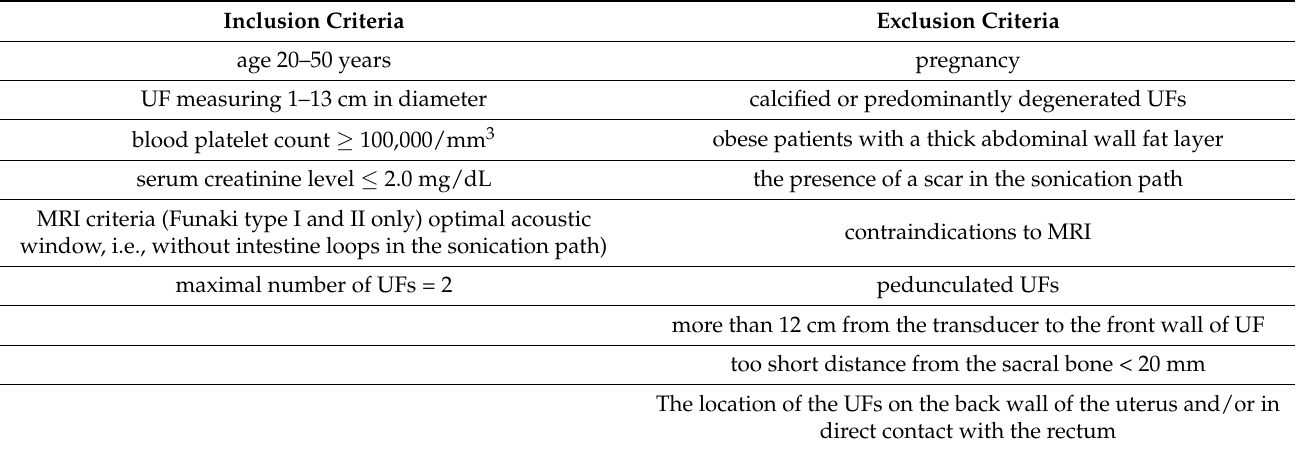
Table 1. Inclusion and exclusion criteria for MR-HIFU